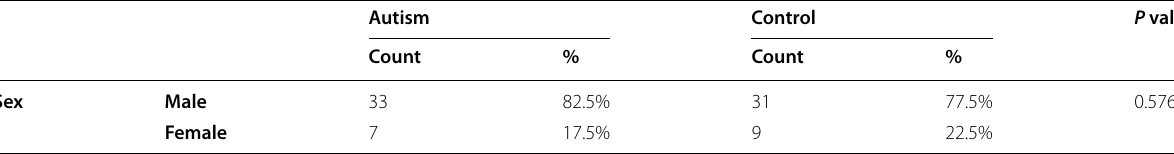
NB P value less than 0.05 is considered statistically significant